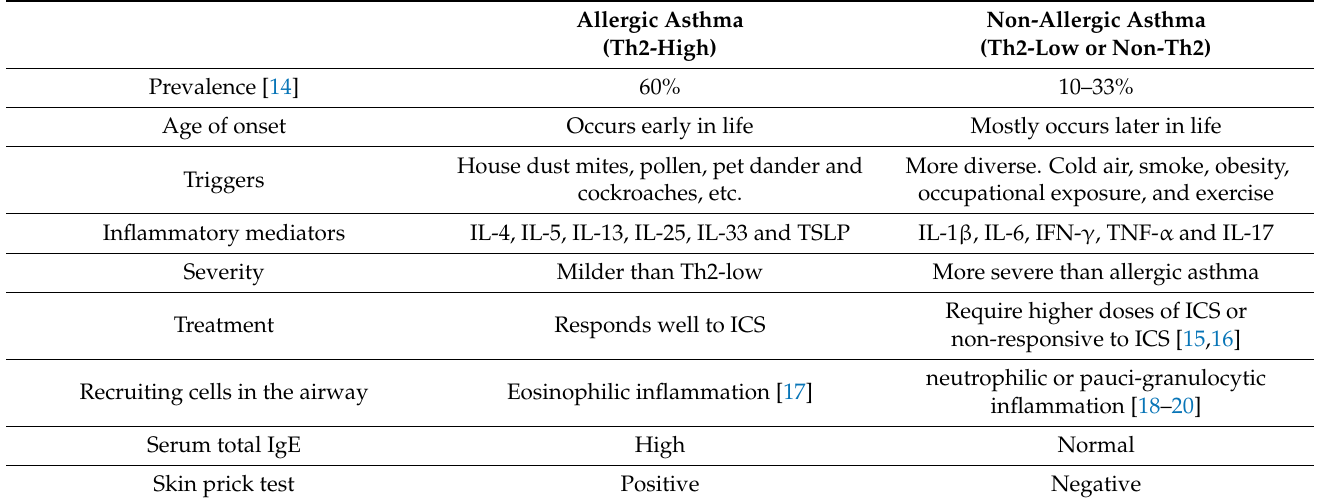
Table 1. Clinical and laboratory characteristics differentiating allergic vs. non-allergic